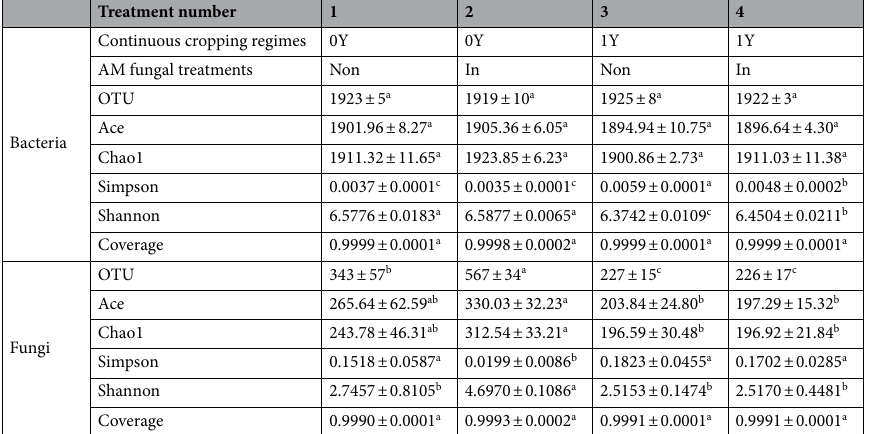
The three replicates of each rhizosphere soil sample were mixed into one sample. From the four rhizosphere soil samples, twenty different bacterial phyla were detected (Fig. 3a). As shown in Fig. 3a, the most dominant bacterial phyla in the four rhizosphere soil samples were Proteobacteria, Acidobacteria and Actinobacteria. Chloroflexi, Gemmatimonadetes and Bacteroidetes were the following dominant phyla in the rhizosphere soil samples except for In0YSB. Gemmatimonadetes (9.53%) was the fourth dominant phylum, followed by Chloro- flexi (8.65%) and Bacteroidetes (3.99%) in In0YSB. The relative abundances of the other dominant phyla in the four rhizosphere soil samples varied under the effects of R. intraradices and continuous cropping. Notably, the relative abundance of Verrucomicrobia had an advantage in the rhizosphere soil samples except Non1YSB. In addition, the relative abundance of Nitrospirae increased from 0.97% in Non1YSB to 2.12% in In0YSB. At the genus level, the most dominant genus was uncultured_bacterium_c_Subgroup_6 in all the rhizos- phere soil samples (Fig. 3b). The relative abundance of Sphingomonas (7.12%) in In0YSB was much higher than the other three rhizosphere soil samples. Furthermore, Gemmatimonas (2.90%), Nitrospira (2.12%), Bryobacter (1.86%), Haliangium (1.23%), and Arthrobacter (0.95%) were also detected in In0YSB. Nevertheless, the relative abundance of Gemmatimonas decreased and remained at about 1.01% in Non1YSB. Due to the inoculation of R. intraradices , the relative abundances of Gemmatimonas , Nitrospira and Arthrobacter in In0YSB and In1YSB were higher than that in Non0YSB and Non1YSB, respectively. It showed that R. intraradices might have effects on the composition of bacterial communities in the rhizosphere soil samples in this study. As shown in Fig. 3b there were also differences in the relative abundances of these dominant genera between the rhizosphere soil samples of continuous cropping and non-continuous cropping soybean. The results showed that the composition of bacterial communities was affected by R. intraradices and soybean continuous cropping. According to the heatmap diagram of the bacterial communities at the genus level, the four rhizosphere soil samples were divided into two clusters: Non0YSB and In0YSB clustered together; Non1YSB and In1YSB clustered together, indicating that the bacterial communities between the two rhizosphere soil samples were similar (Fig. 4). The results also demonstrated that both R. intraradices and continuous cropping could affect the dominant genera and their relative abundances in the four rhizosphere soil samples.